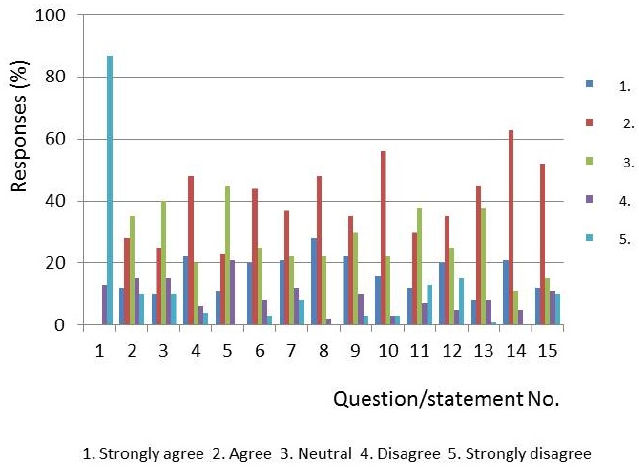
Figure 9. Chart showing survey results (N = 29).